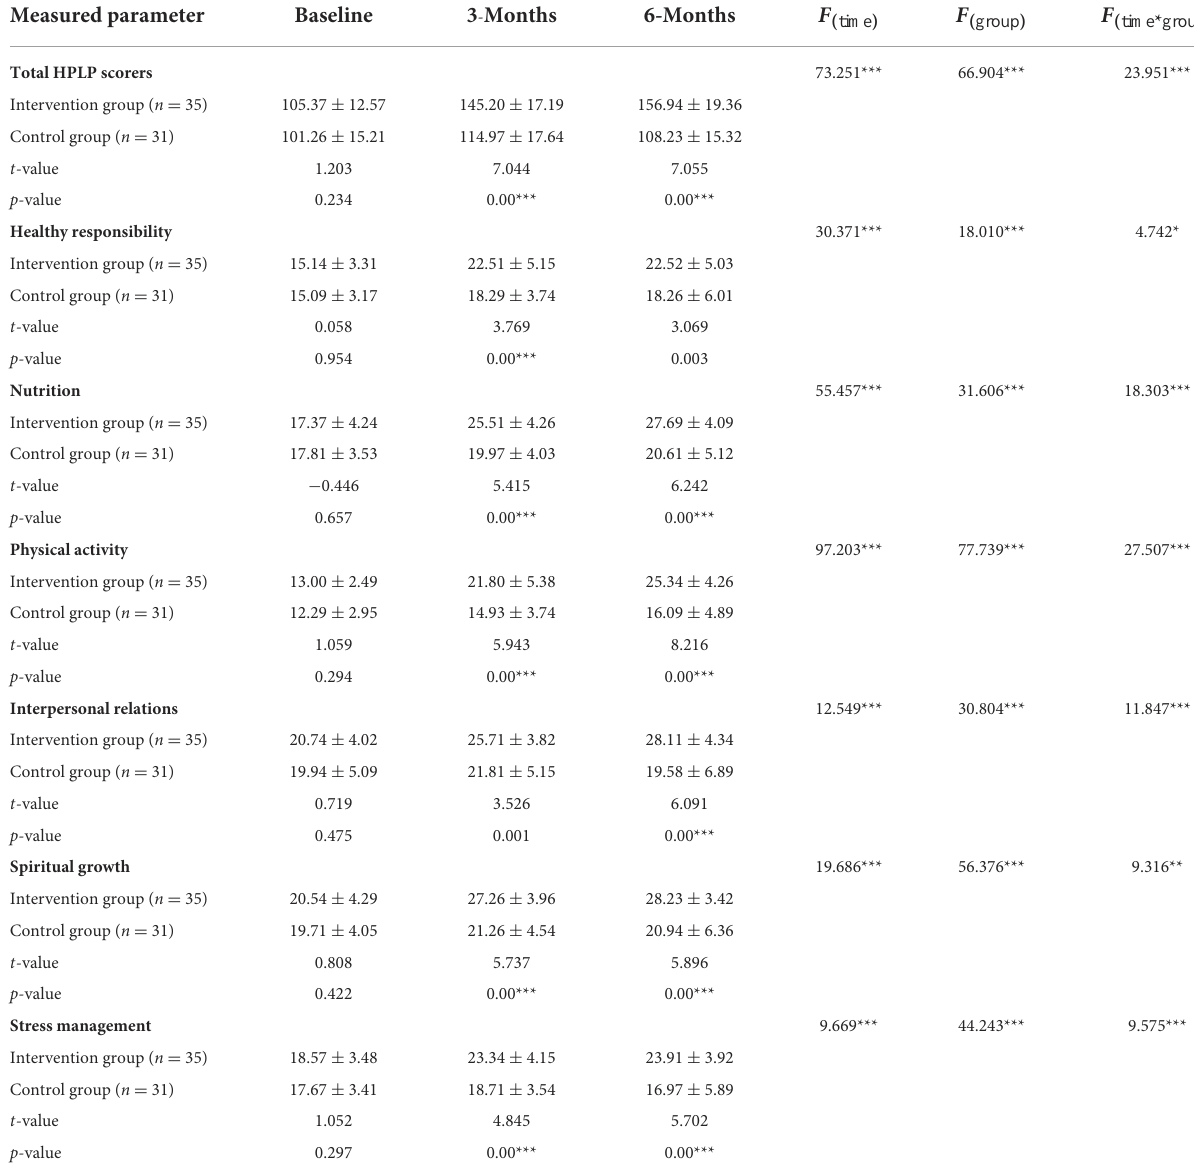
TABLE 2 Comparison of HPLP-II score at baseline, third, and sixth